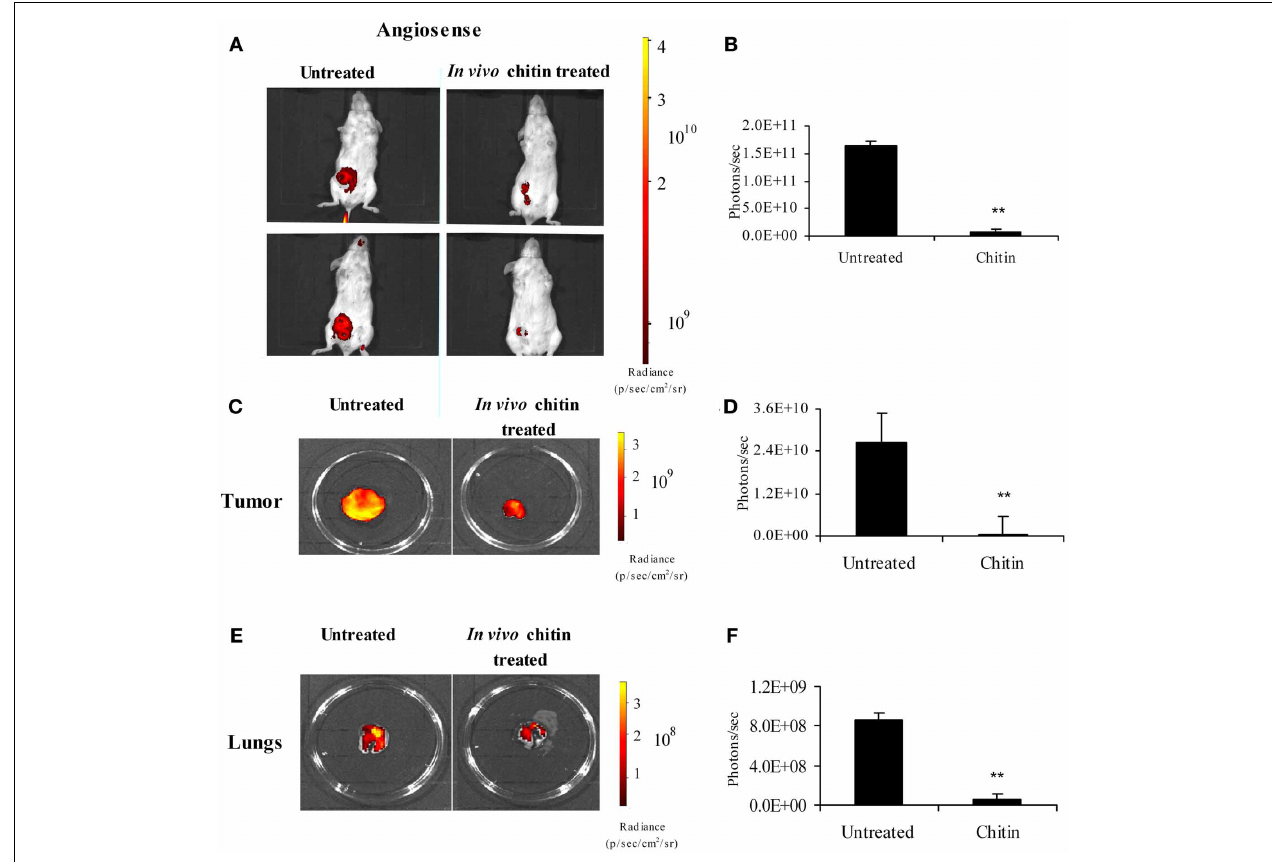
FIGURE 7 | In vivo treatment with chitin microparticles decreases angiogenesis. 4T1 mammary tumor bearers at 5 weeks post-tumor implantation were treated in vivo with chitin microparticles (1mg/mL) and analyzed for angiogenesis using AngioSense probe by in vivo imaging system. (A) Ventral image of untreated and chitin treated mammary tumor bearing mice showing 2 out 5 mice/treatment group; (B) Quantification (photons/s) of AngioSense specific fluorescent signal indicating decreased angiogenesis at 21 days post-tumor implantation in the chitin treated group; (C) Excised tumors from untreated and chitin treated